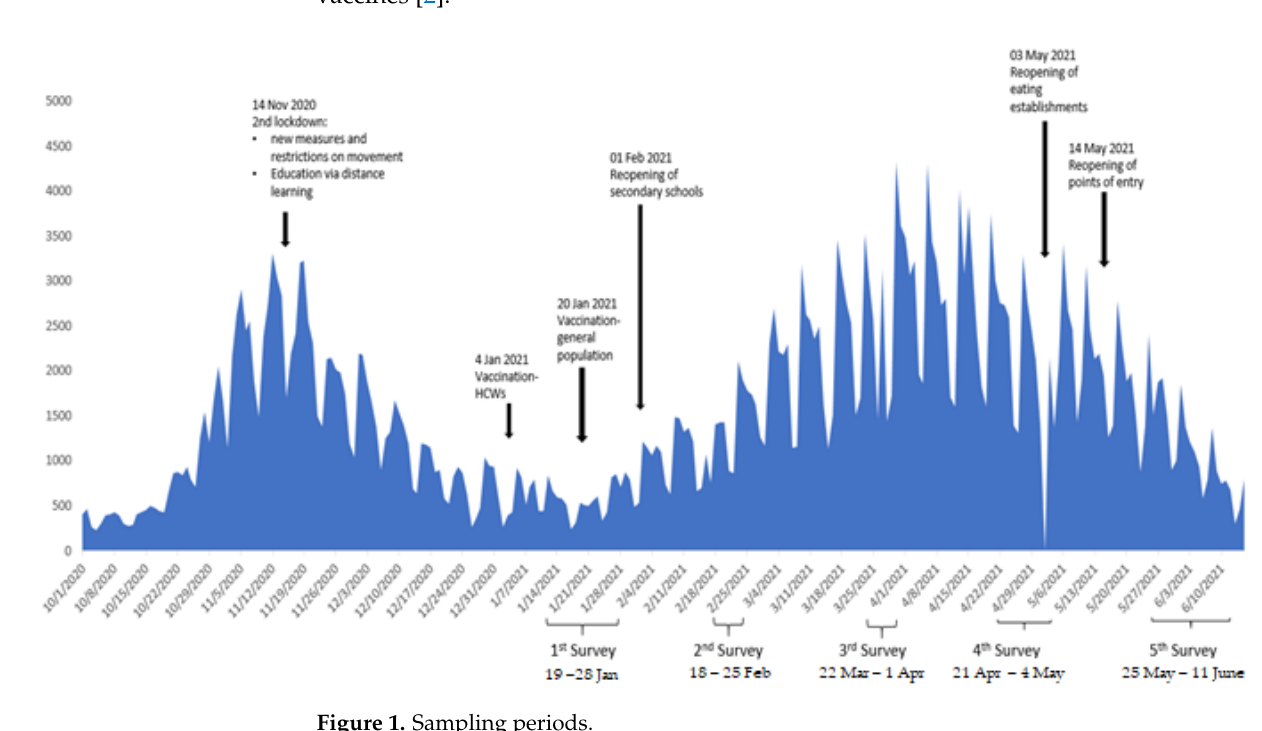
Figure 1. Sampling